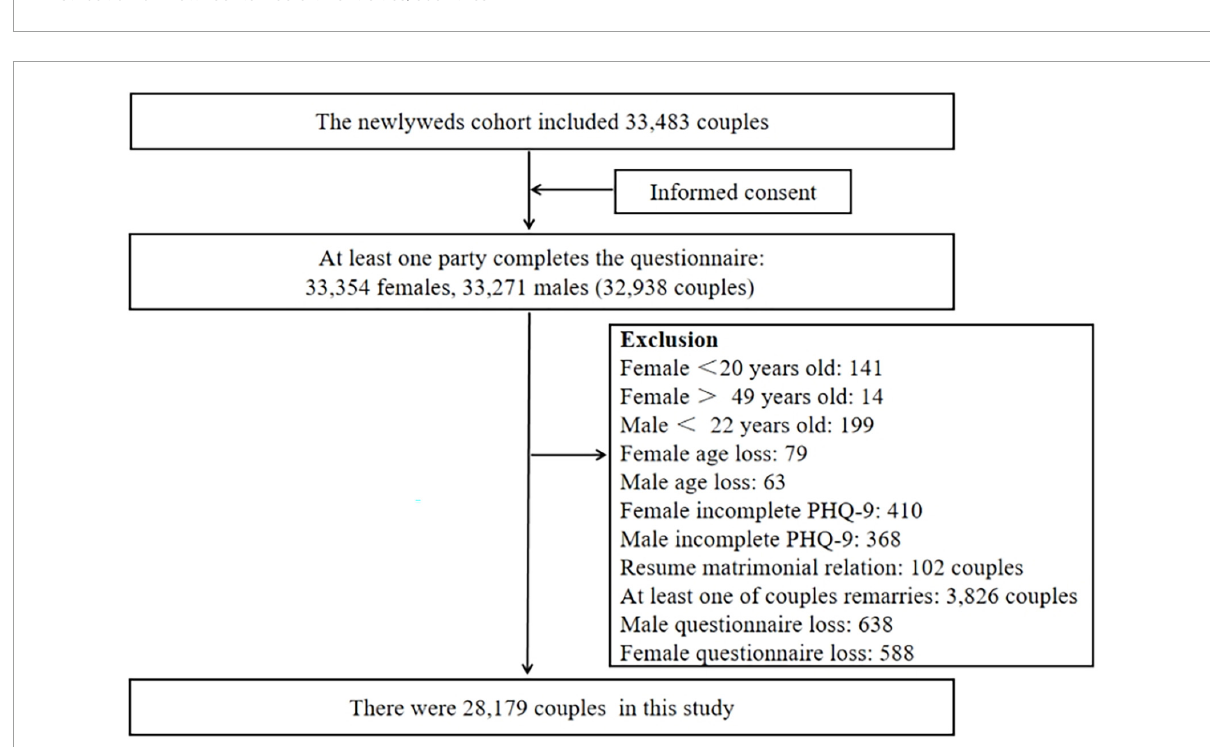
FIGURE2 Selection of the study population. PHQ-9, 9-item Patient Health